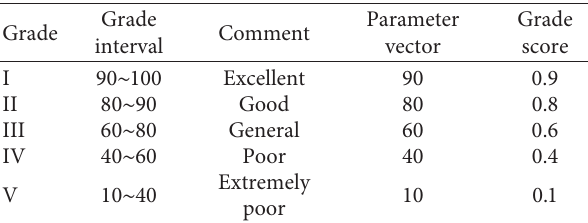
Table 5: Grade parameter vector corresponding grade